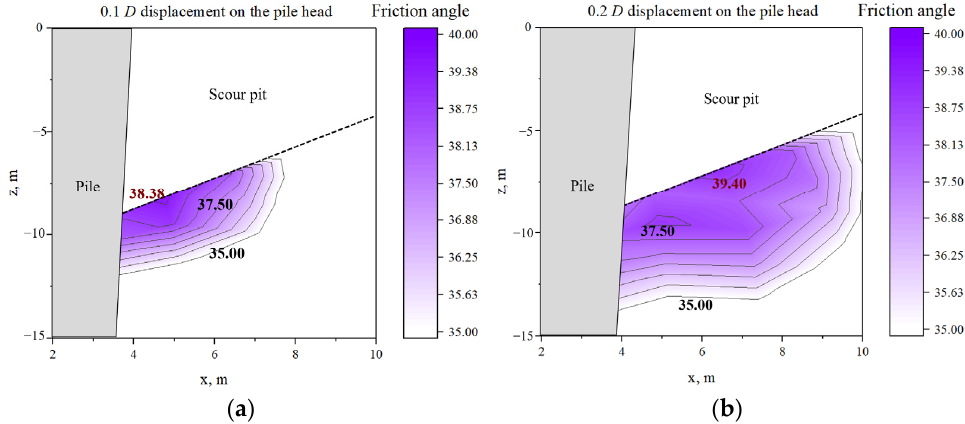
Figure 13. The friction angle contour at the pile head displacement of ( a ) 0.1 𝐷 ; ( b ) 0.2 𝐷 in local scour condition.